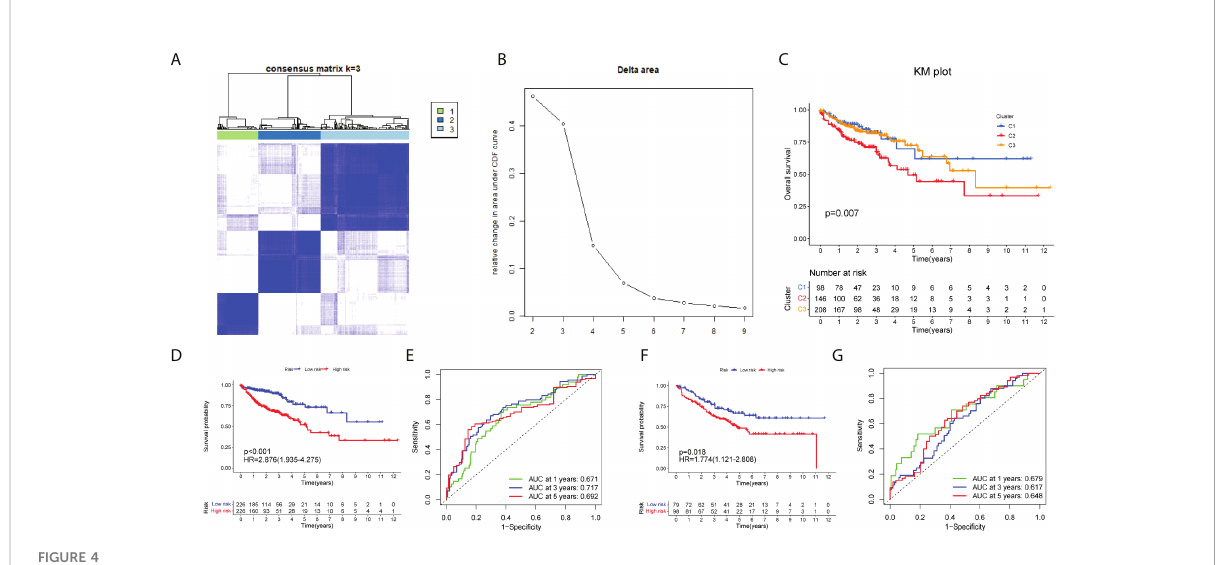
FIGURE 4 Identi fi cation of m7G-associated clusters and prognostic analysis between clusters. (A) The consensus matrix (k = 3) of 452 COAD samples by Consensus Cluster analysis. (B) The relative change in area under the CDF curve for k = 2 – 10. The KM plot showing overall survival in three clusters (C) , training set (D) , and test set (F) .The ROC curve of the training set (D) and test set (F) . The 1-, 3-, and 5-year ROC analyses of risk score in the training set (E) and test set (G)